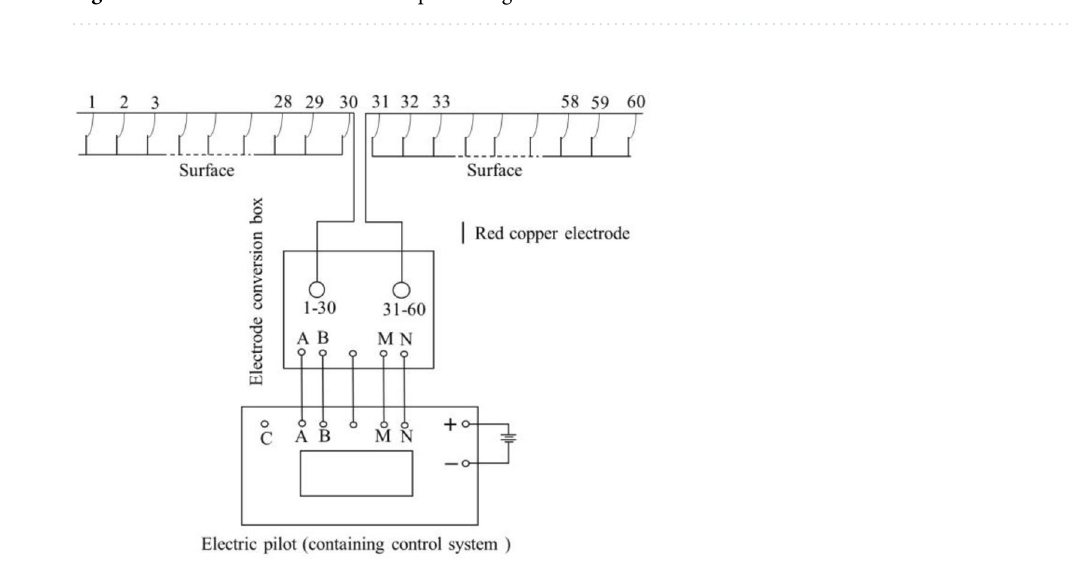
Figure 4. The flow chart of TEM data processing.